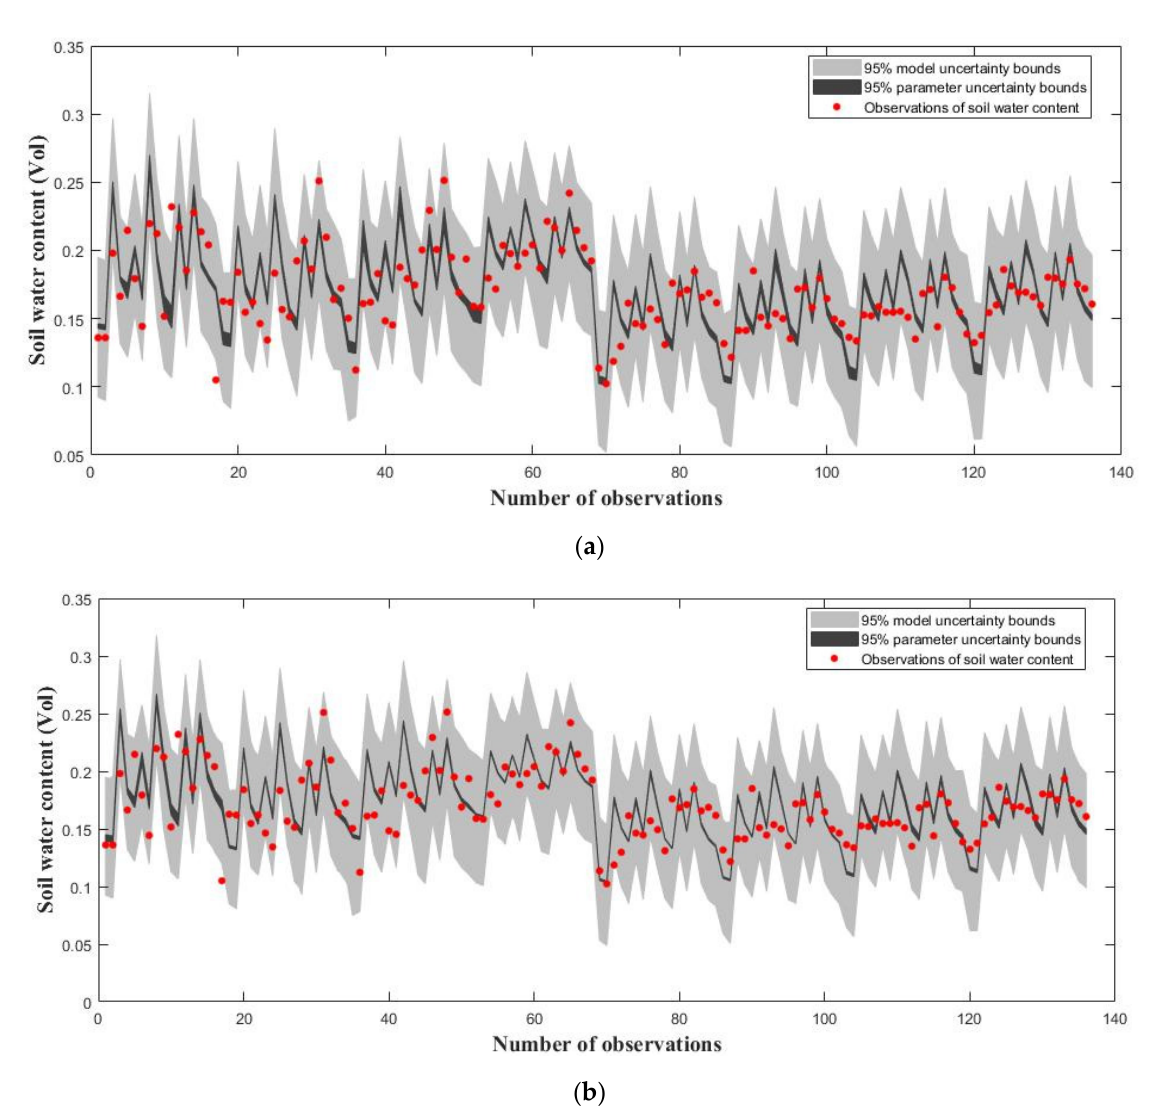
Figure 6. Plots of simulated and reference soil water content. 95% simulation uncertainty intervals due to parameter (dark region) and total uncertainty (light gray). The measured soil water content values are indicated with red points. ( a ) DiffeRential Evolution Adaptive Metropolis with Kalman-inspired proposal distribution (DREAMkzs); ( b ) DiffeRential Evolution Adaptive Metropolis (DREAMzs).